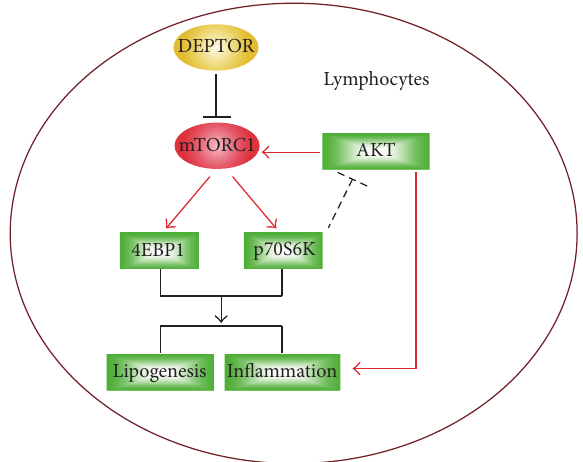
Figure 5: Schematic representation explaining the network of DEP- TOR, mTORC1, mTORC2, and lipogenesis/inflammation networks. DEPTORisanaturalinhibitorofmTORC1pathway.Overexpression of mTORC1 inhibitor DEPTOR may partly reduce mTORC1 activity but may not decrease lipogenesis and inflammation. Addition of AKT inhibitors may decrease lipogenesis and inflammation in DEPTOR overexpressed cells. Moreover, DEPTOR knockdown may activate mTORC1 and increase lipogenesis and